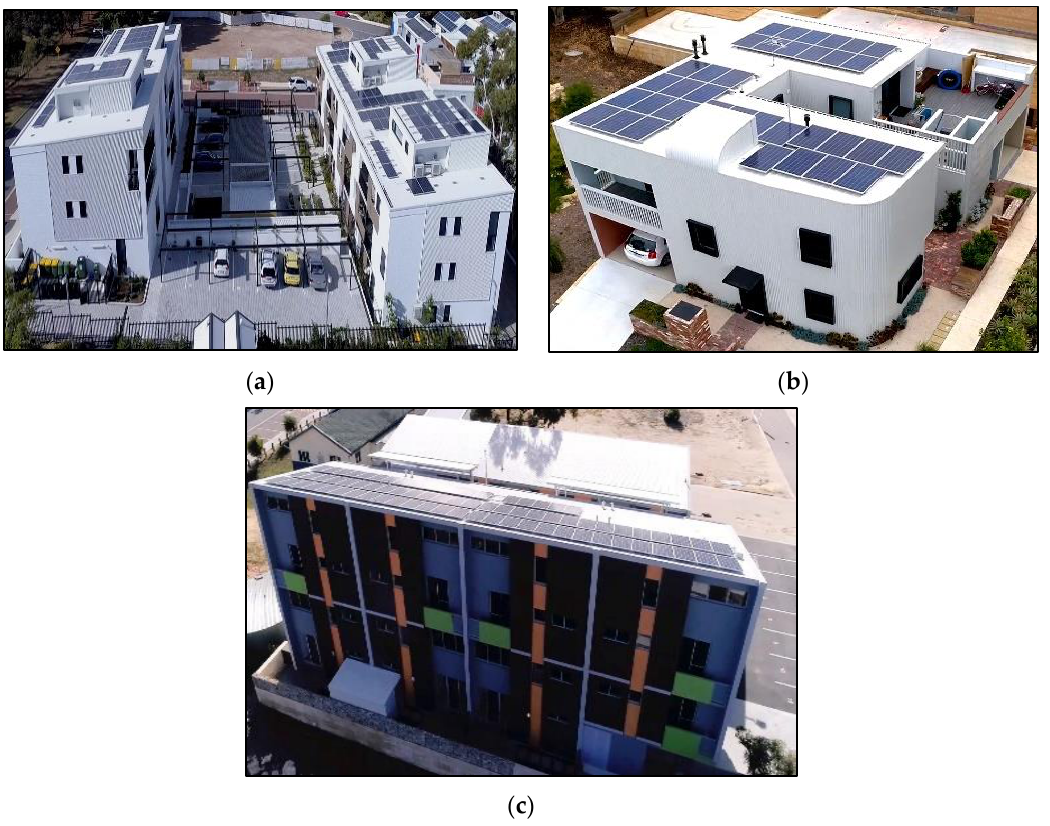
Figure 1. Apartment complexes investigated in this study: ( a ) Evermore (24 apartments), ( b ) Gen Y (3 apartment units), and ( c ) SHAC (12 apartments, 2 studios).